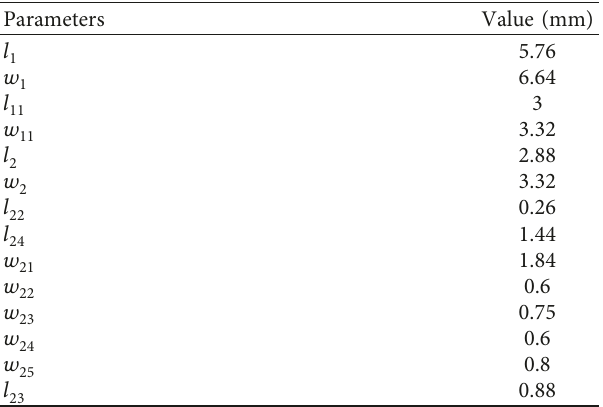
Table 1: The parameters of the proposed antenna structure.